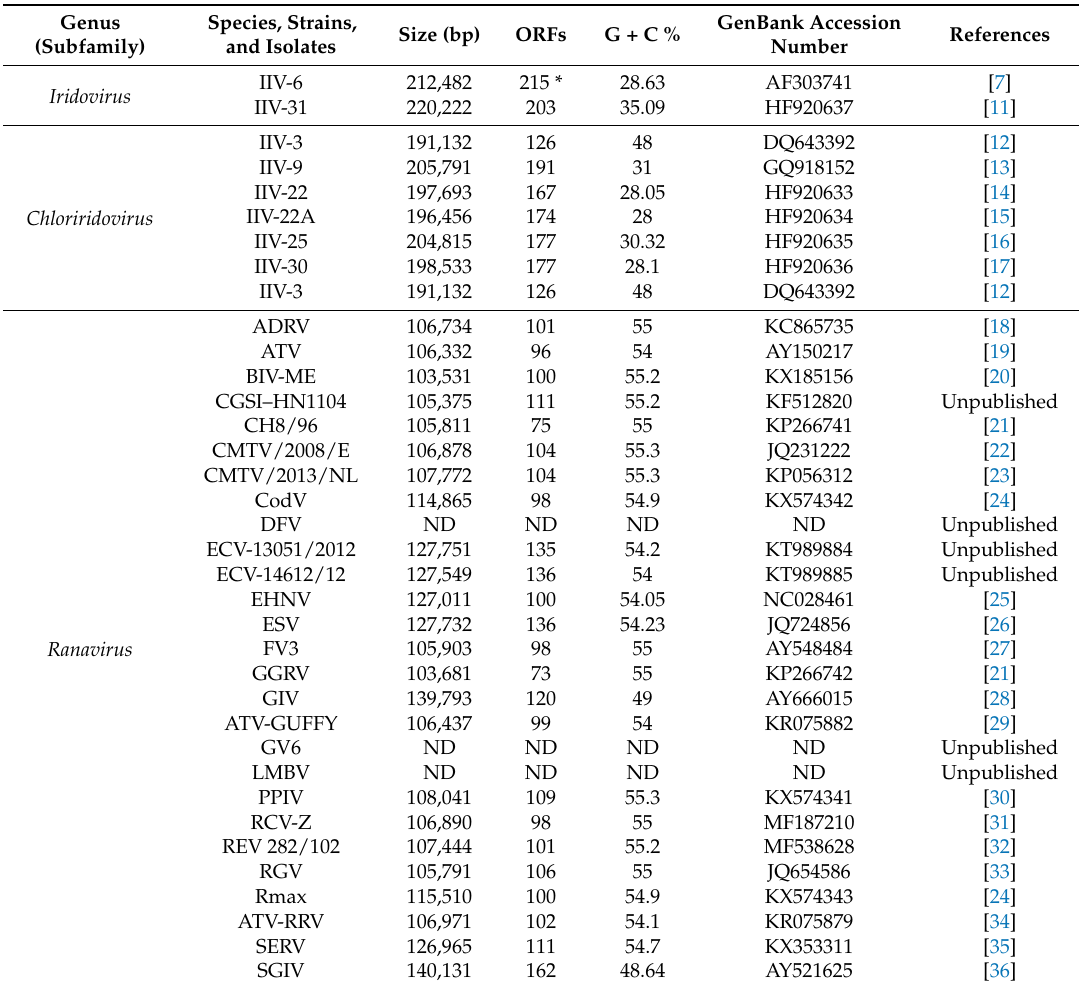
Table 2. Identified iridovirids with complete genome sequences. IIV-6—Invertebrate iridescent virus 6; IIV-31—Invertebrate iridescent virus 31; IIV-3—Invertebrate iridescent virus 3; IIV-9—Invertebrate iridescent virus 9; IIV-22—Invertebrate iridescent virus 22; IIV-22A—Invertebrate iridescent virus 22A; IIV-25—Invertebrate iridescent virus 25; IIV-30—Invertebrate iridescent virus 30; ADRV—Andrias davidianus ranavirus; ATV—Ambystoma tigrinum virus; BIV-ME—Bohle iridovirus isolate ME 93/35; CGSI-HN1104—Chinese giant salamander iridovirus